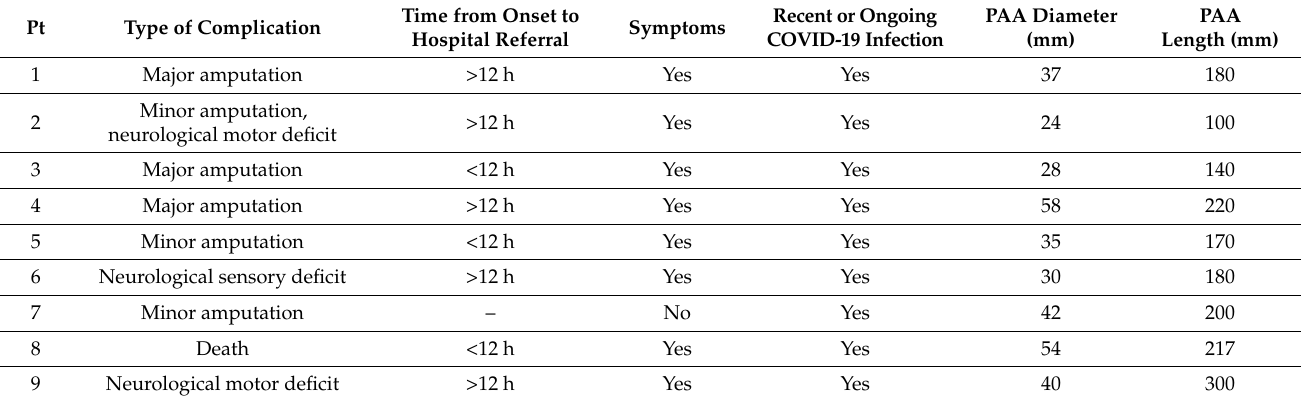
Table 2. Data on nine patients reporting complications after invasive